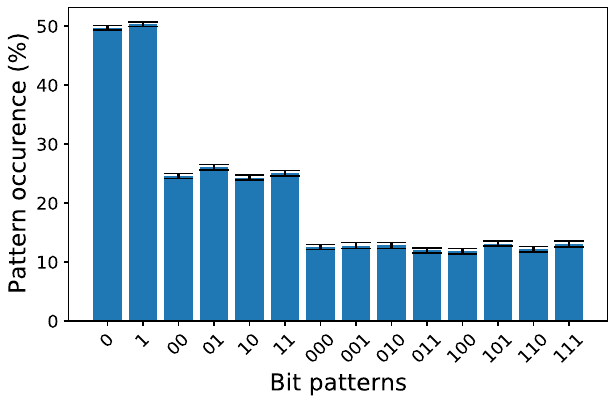
Fig. 3 In-orbit data analysis. We analyze 66 runs of randomness beacon containing total 16,896 bits generated in orbit. For a limited data set of this size, tests such as “ Dieharder ” provide little meaningful insight. Instead, it is useful to compute the relative frequencies of occurrences of all binary sub- strings of length 1, 2, 3, … (the so-called Borel normality condition 34 ). This analysis indicates a uniform distribution within error bars limited by fi nite sample